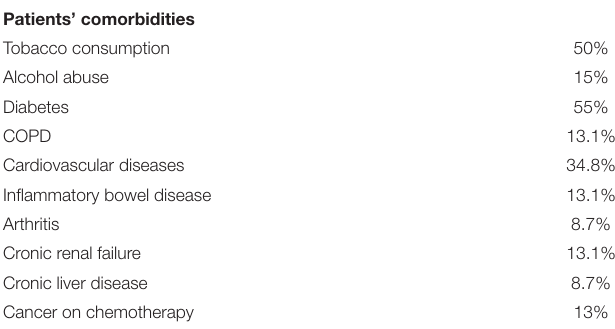
TABLE 3 | Patients’